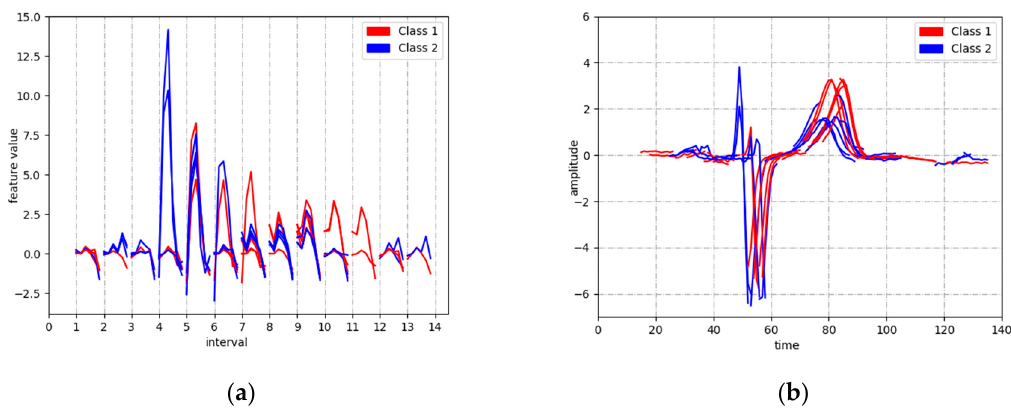
Figure 7. ( a ) Sixty-eight feature vectors extracted by the proposed method. ( b ) Interval features found by the proposed